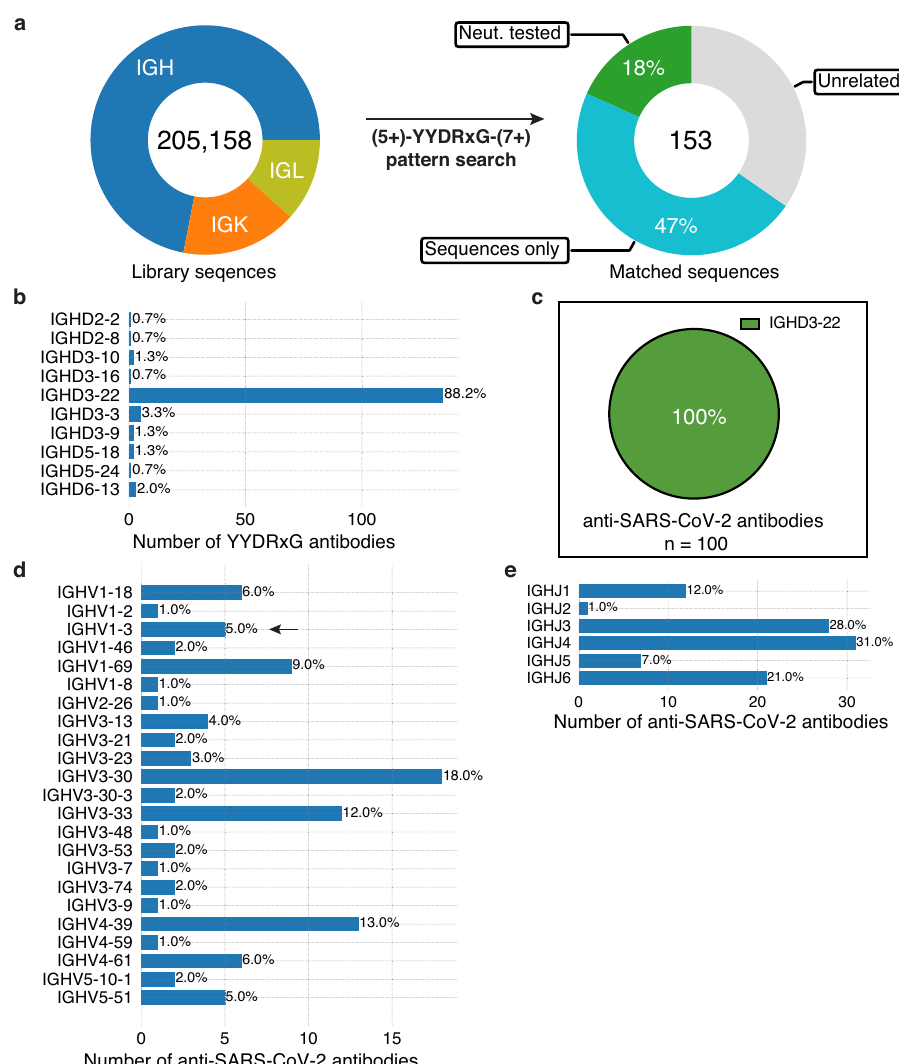
Fig. 3 A YYDRxG pattern search identi fi es antibodies where the D region is encoded mostly by IGHD3-22. a Over 205,000 publicly available antibody sequences were retrieved from GenBank and supplementary fi les of previous publications reporting human anti-SARS-CoV-2 antibodies. The compiled antibody sequence library consists of 72% heavy chains (IGH), 16.4% kappa chains (IGK), and 11.7% lambda chains (IGL). CDR3 amino-acid sequences were used to search for the YYDRxG motif with fi ve or more amino acid residues prior and seven or more amino acid posterior to the hexad motif. 153 heavy chain sequences were identi fi ed that contain a YYDRxG pattern and followed by data curation with literature review. 65% (100) are antibodies isolated from COVID-19 patients and mRNA vaccinees. 28 (18%) have been validated for SARS-CoV-2 neutralization (Neut. tested), while 72 (47%) have not (sequences only). b YYDRxG antibodies are mostly encoded by the IGHD3-22 gene. All of the D genes used by YYDRxG antibodies were counted. Numbers at the right side of each bar indicate the percent of the total of identi fi ed YYDRxG antibodies. c IGHD3-22 encodes all YYDRxG antibodies against SARS-CoV-2. All 100 sequences of anti-SARS-CoV-2 antibodies were analyzed and counted. d , e Heavy chain variable ( d IGHV) and joining ( e IGHJ) genes of YYDRxG antibodies isolated from COVID-19 patients or vaccinees. A diverse but limited set of variable and joining genes pair with IGHD3-22 in YYDRxG antibodies against SARS-CoV-2. IGHV3-30, IGHV4-39, IGHV3-33 , and IGHV1-69 are more frequently found than others. Arrows indicates the immunoglobulin genes that encode ADI-62113 in this